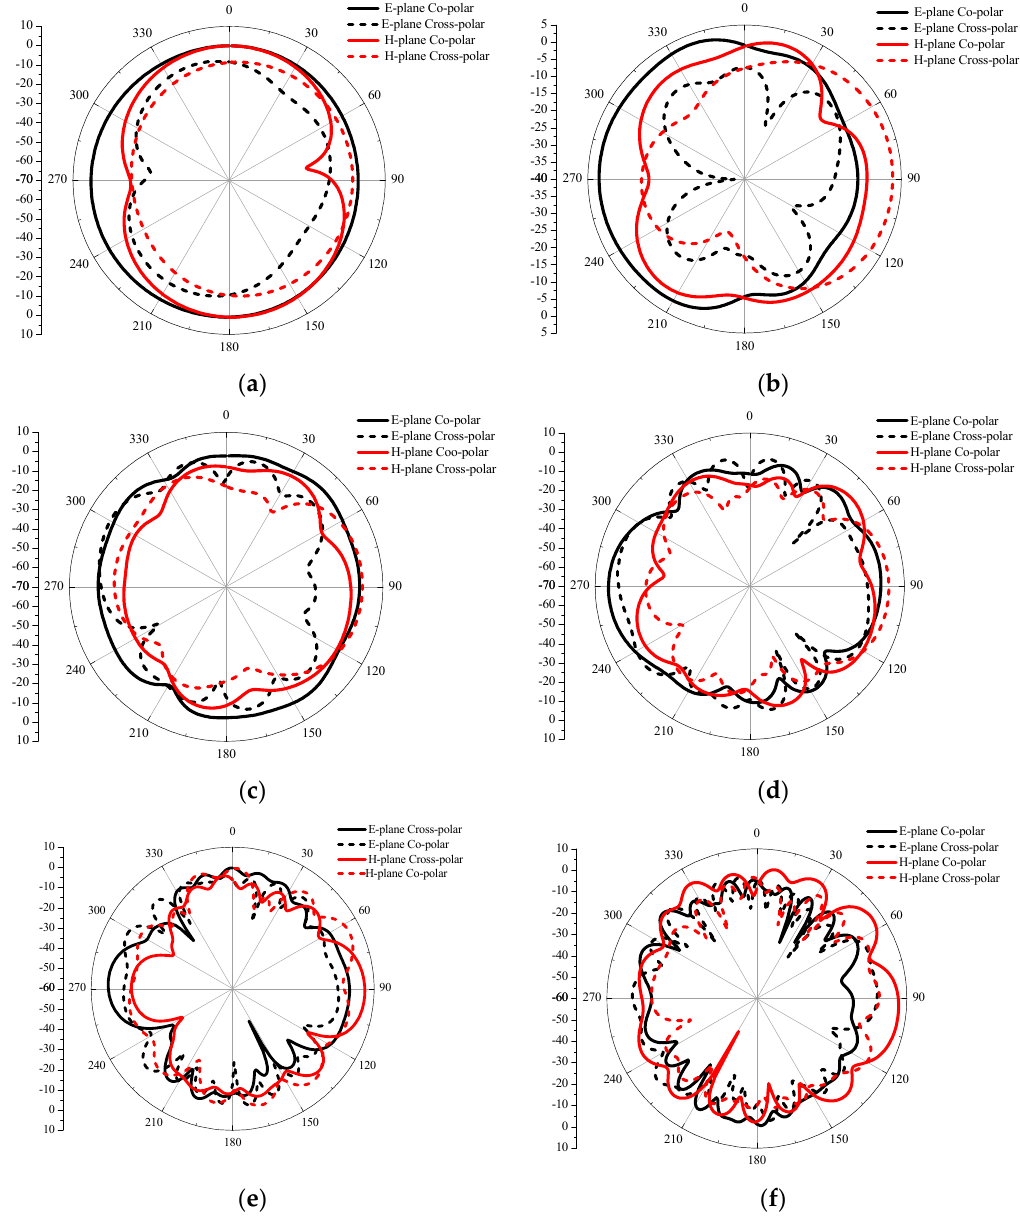
Figure 10. The co- and cross polar pattern in E-plane and H-plane at ( a ) 5 GHz ( b ) 10 GHz ( c ) 15 GHz ( d ) 20 GHz ( e ) 30 GHz, and ( f ) 40 GHz.